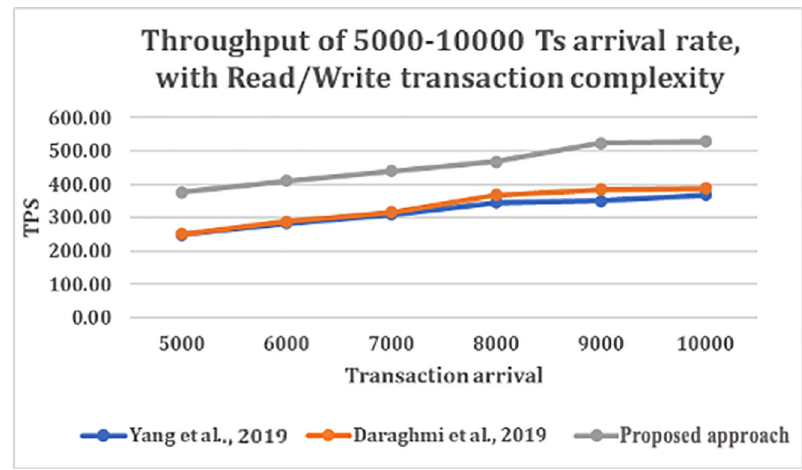
Figure 4. Throughput of 5000 – 10000 transaction arrival rate with read/write